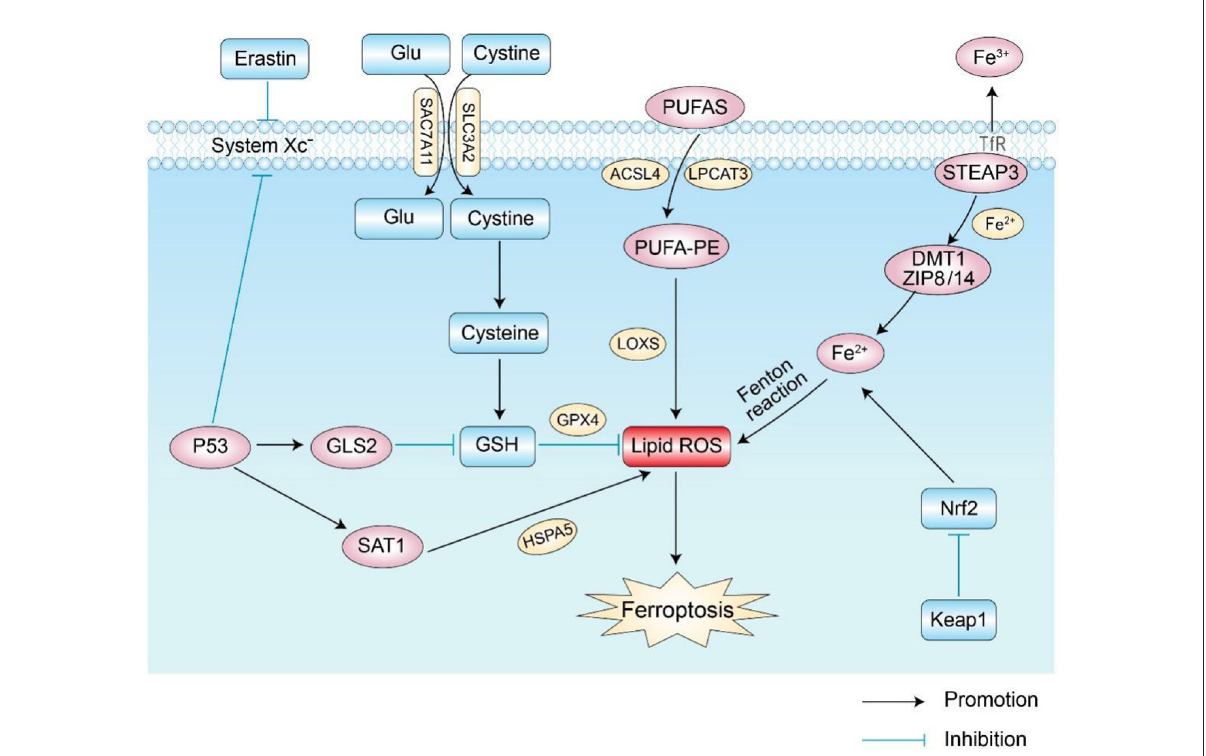
FIGURE1 Main regulatory pathways of ferroptosis. There are two main ways of regulating ferroptosis shown in the figure: the first is the pathway of abnormal iron, amino acid, and lipid metabolism; the second involves the related signaling pathways that regulate ferroptosis, such as the P53 and Nrf2 pathways. Glu, glutamic acid; GSH, glutathione; GPX4, glutathione peroxidase 4; Nrf2, Nuclear factor erythroid 2-related factor 2; GLS2, glutaminase 2; LOXs, lipoxygenases; ROS, reactive oxygen species; DMT1, divalent metal ion transporter-1; SAT1, spermidine N1-acetyltransferase 1; TfR, transferrin